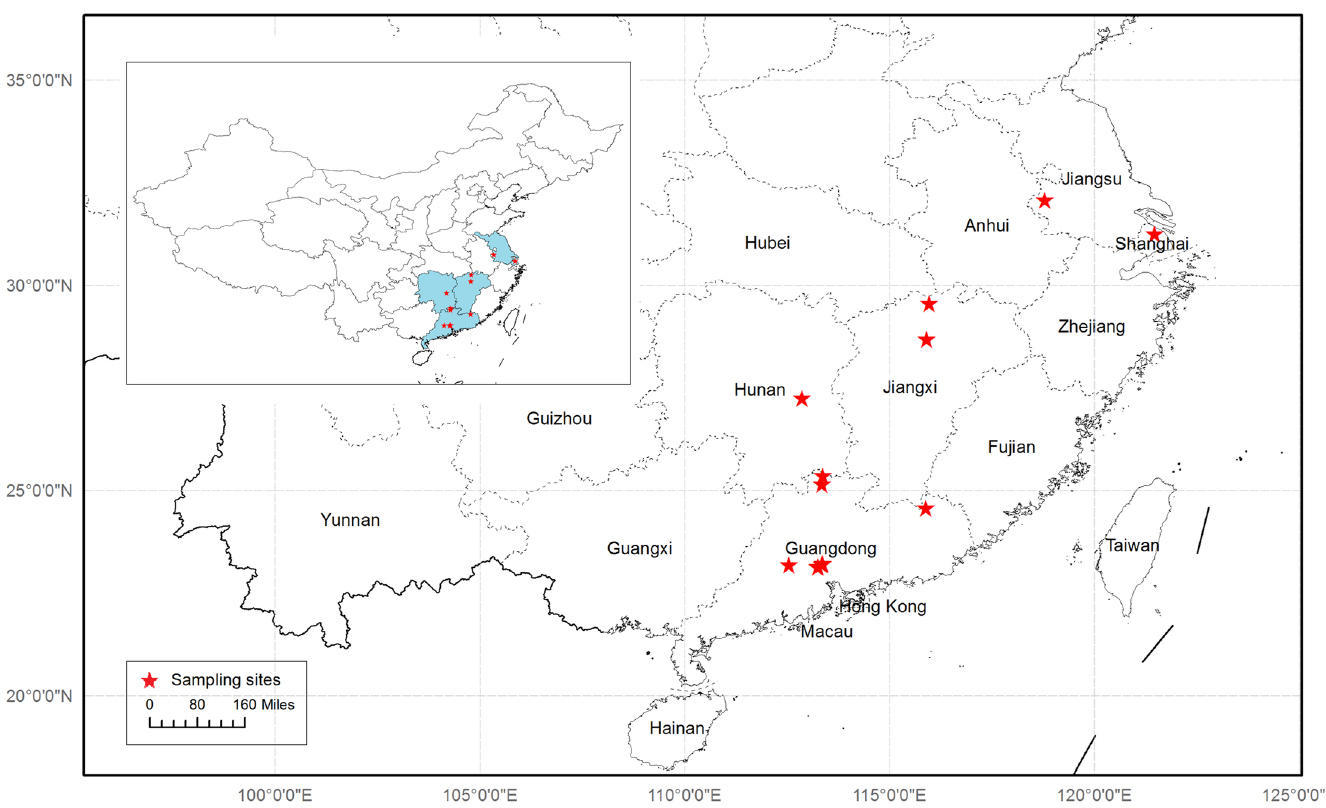
Fig 1. Sampling sites of medicinal plants in South China. Provinces of sampling sites are shadowed in the small map of China.